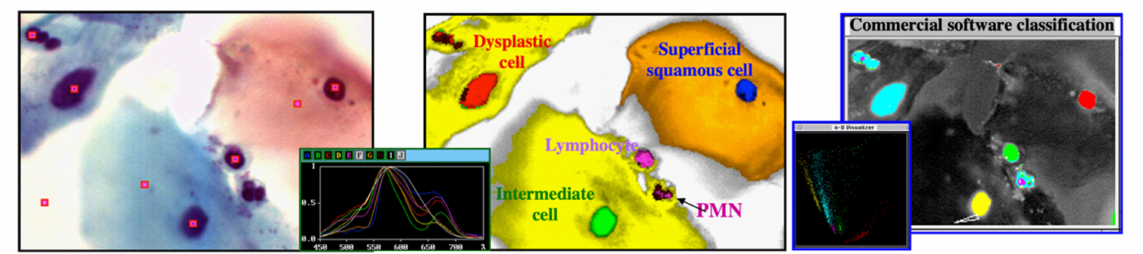
Figure 8. Hyperspectral imaging cytopathology. ( Left ): RGB image of typical Pap smear. This specimen was spectrally imaged and classified using our analysis software ( middle ), revealing the cell types present. The same segmentation and conclusions were obtained by a commercial spectral analysis package (ENVI) using a clustering algorithm (note the different